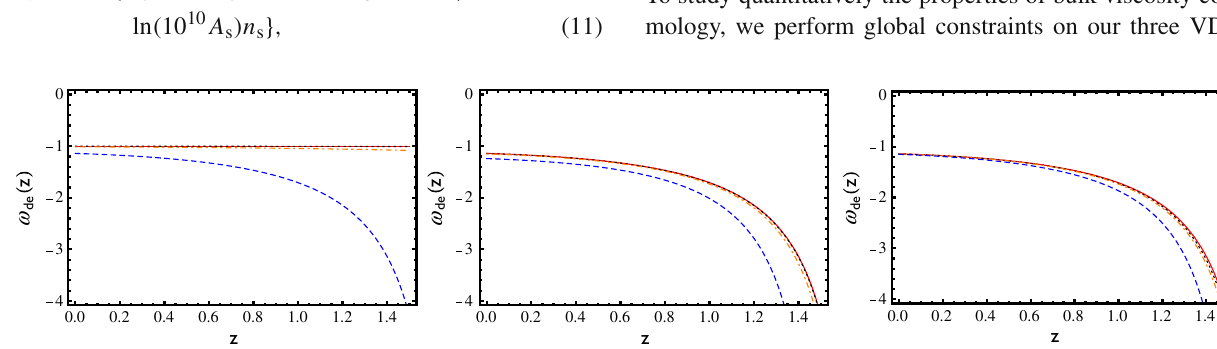
Fig. 4 Left panel The effects of the bulk viscosity coefficient η on the effective EoS of VDE ω de ( z ) in the V (cid:4) DE model. The solid (red), dot- ted (black), dash-dotted (orange) and dashed (blue) lines correspond to the cases of η = 0 ( (cid:4) CDM), 0.001, 0.01 and 0.1, respectively. Middle panel The effects of the perfect EoS of DE ω on the effective EoS of VDE ω de ( z ) in the V ω DE model. Fixing η = 0 . 1, the solid (red), dotted (black), dash-dotted (orange) and dashed (blue) lines correspond to the